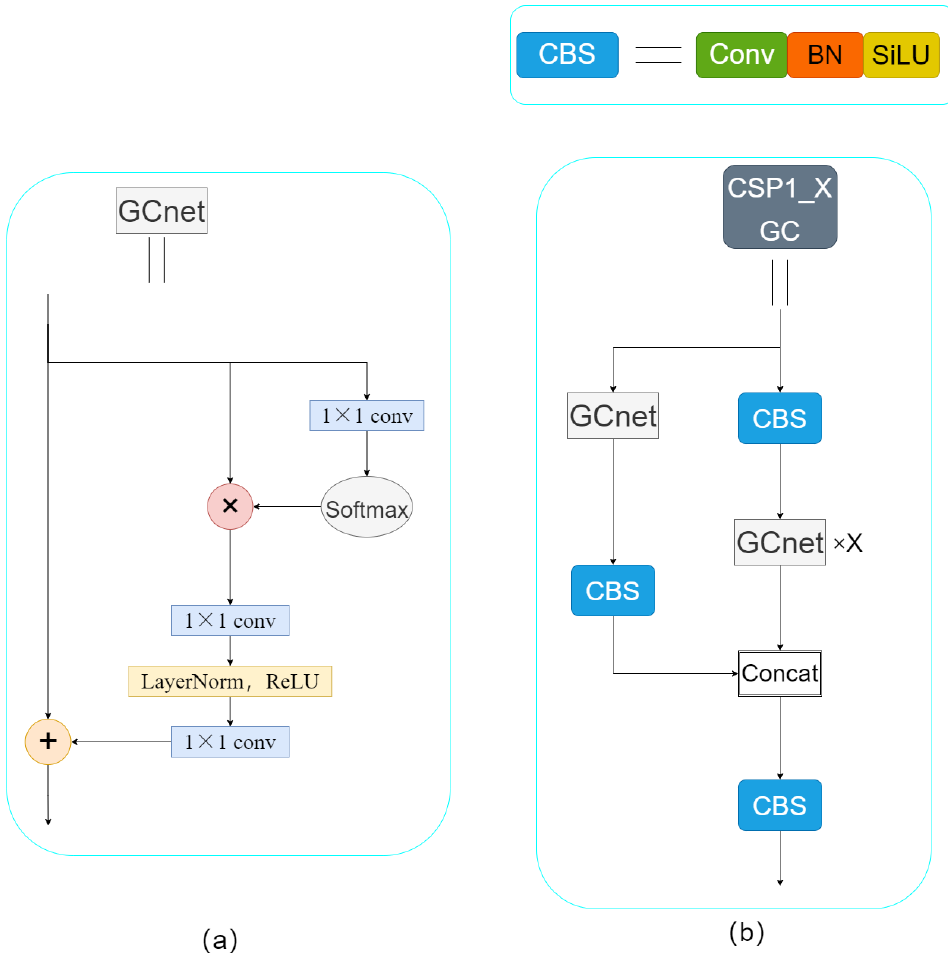
Figure 6. The methods for integrating GCNet. ( a ) The structure of GCNet. ( b )The CSP1 structure of the fused GCNet.